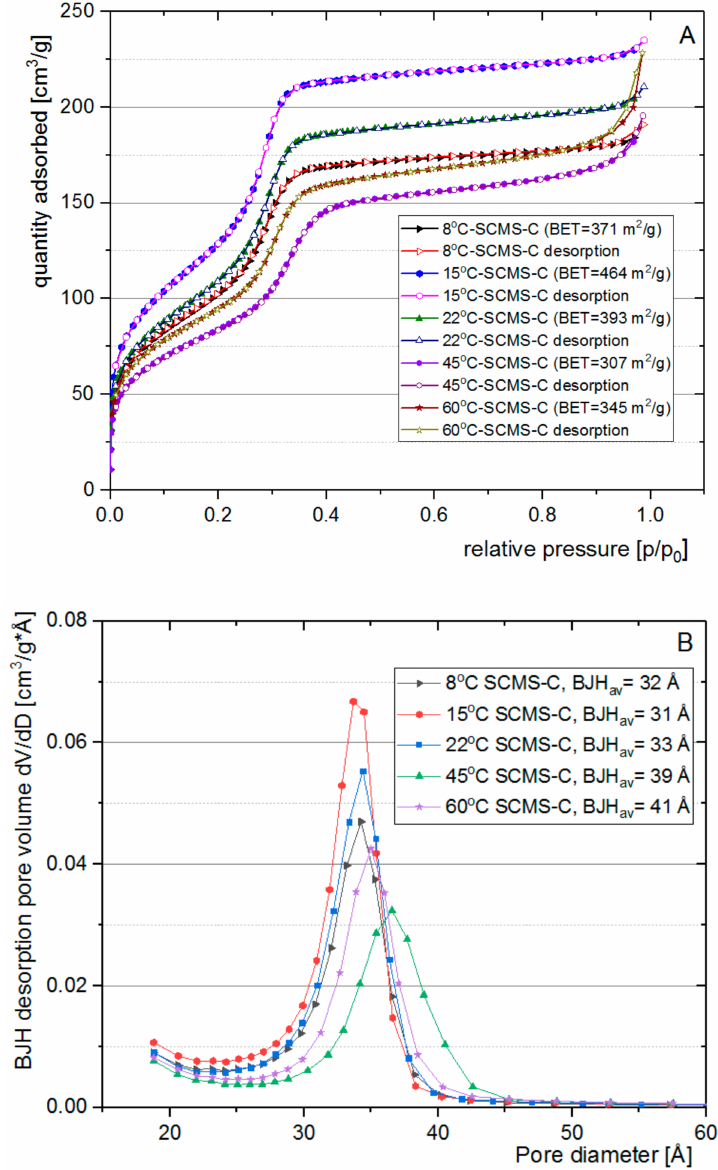
Figure 5. ( A ) N 2 adsorption-desorption isotherms at 77 K for SCMS-C. ( B ) BJH (based on Barrett-Joyner-Halenda theory) pore distribution of SCMS-C